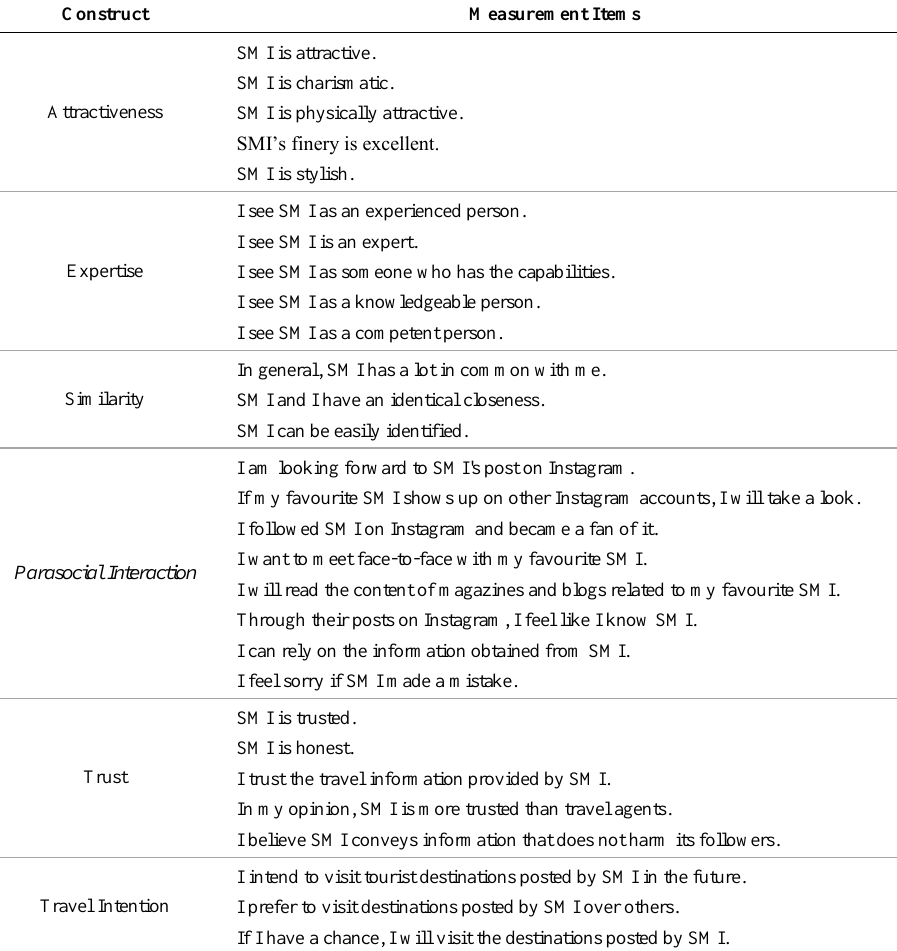
Table 2. Constructs Measurement